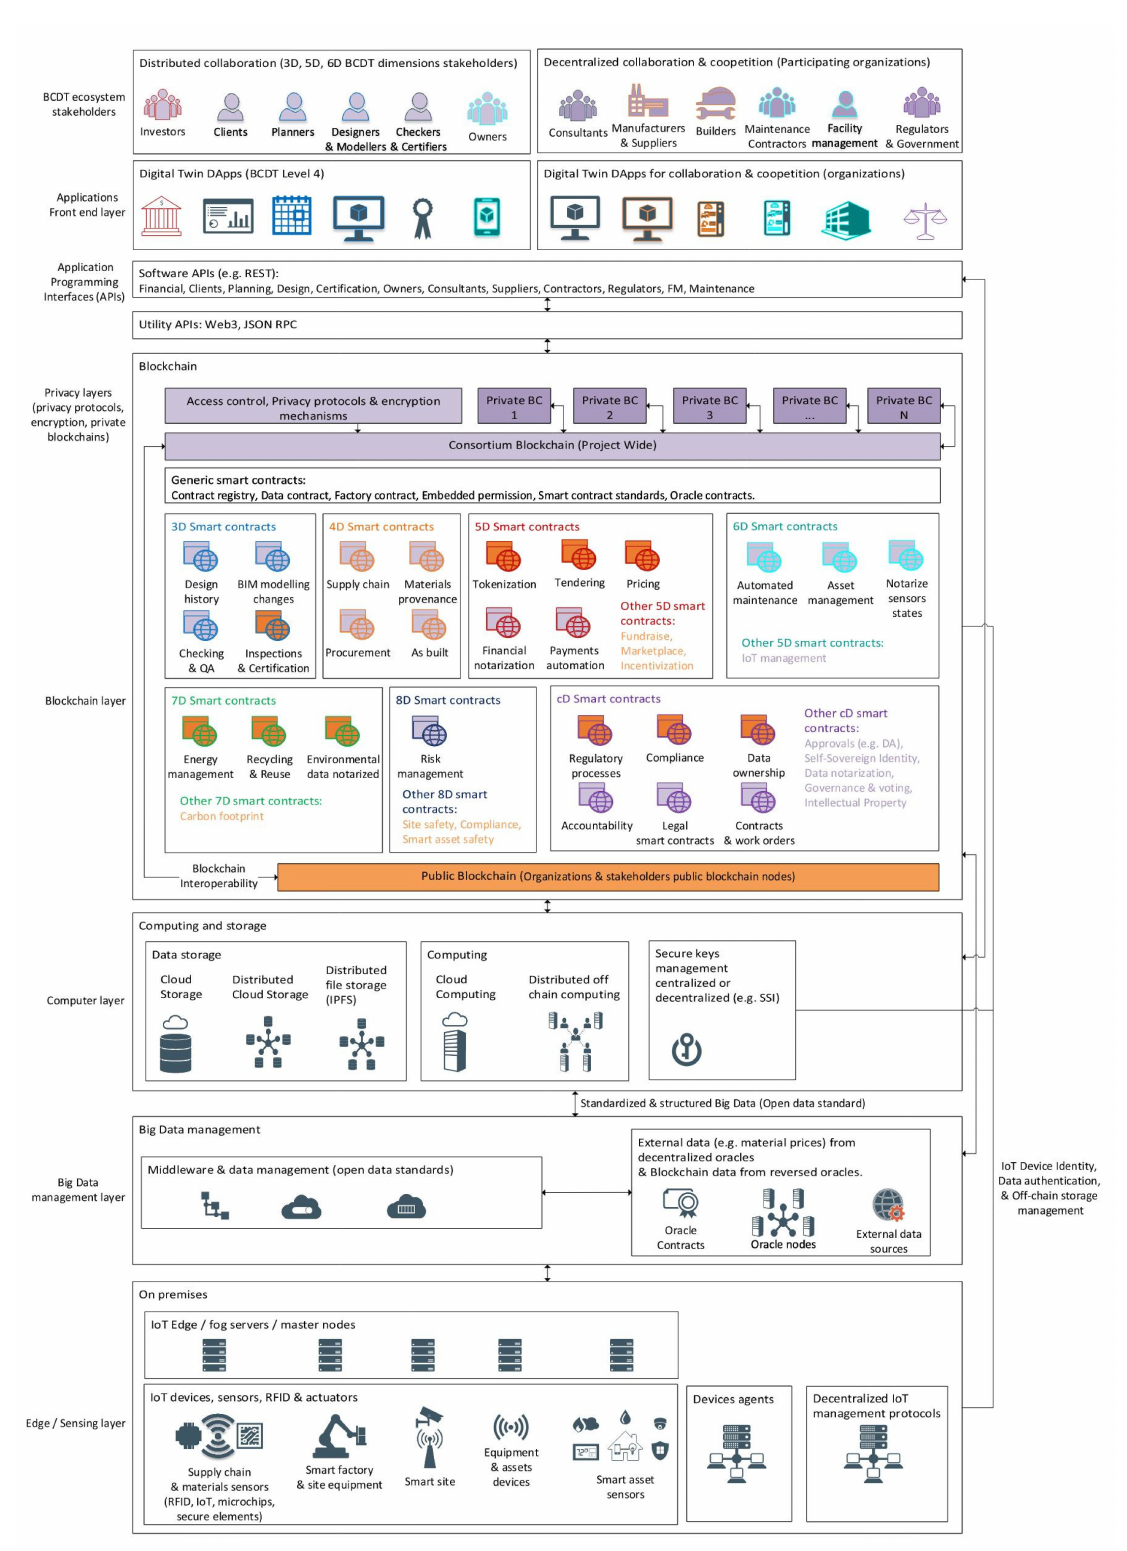
Figure 1. BCDT software